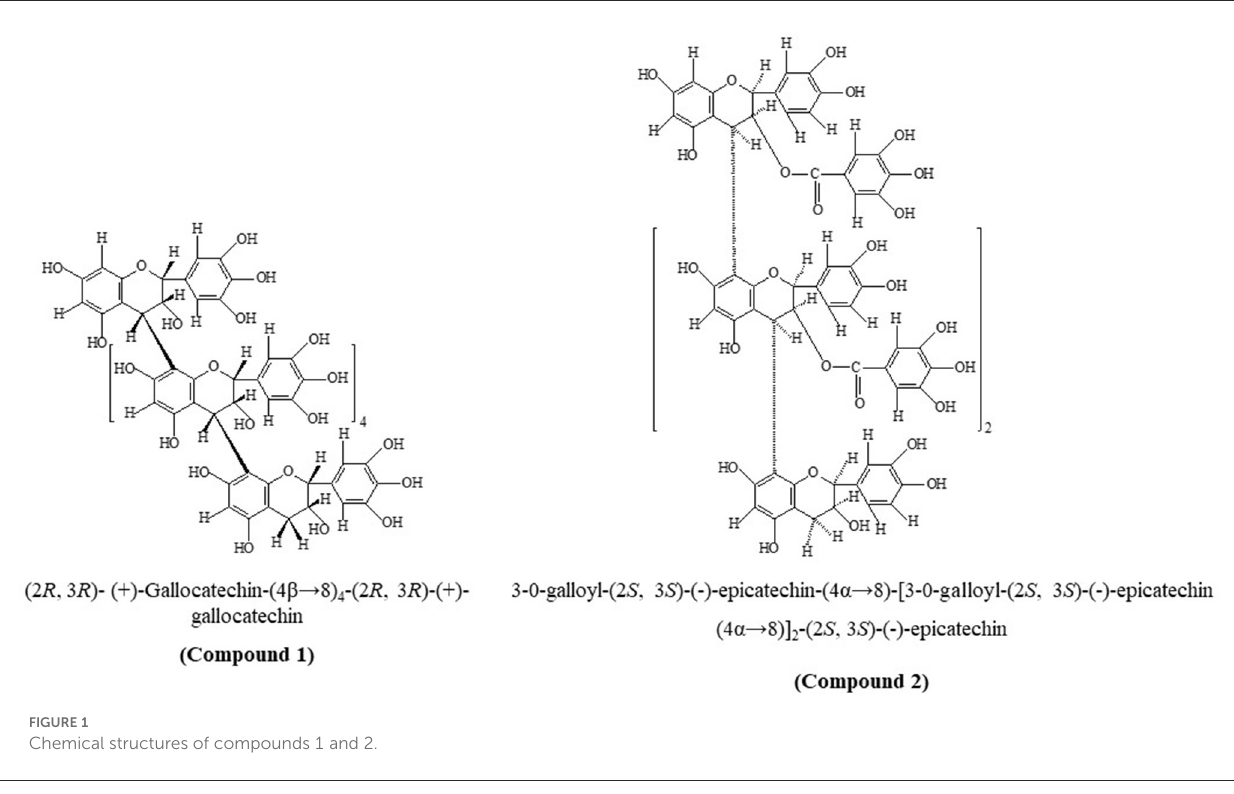
TABLE 2 Physicochemical properties of compounds 1 and 2 and standards used in this